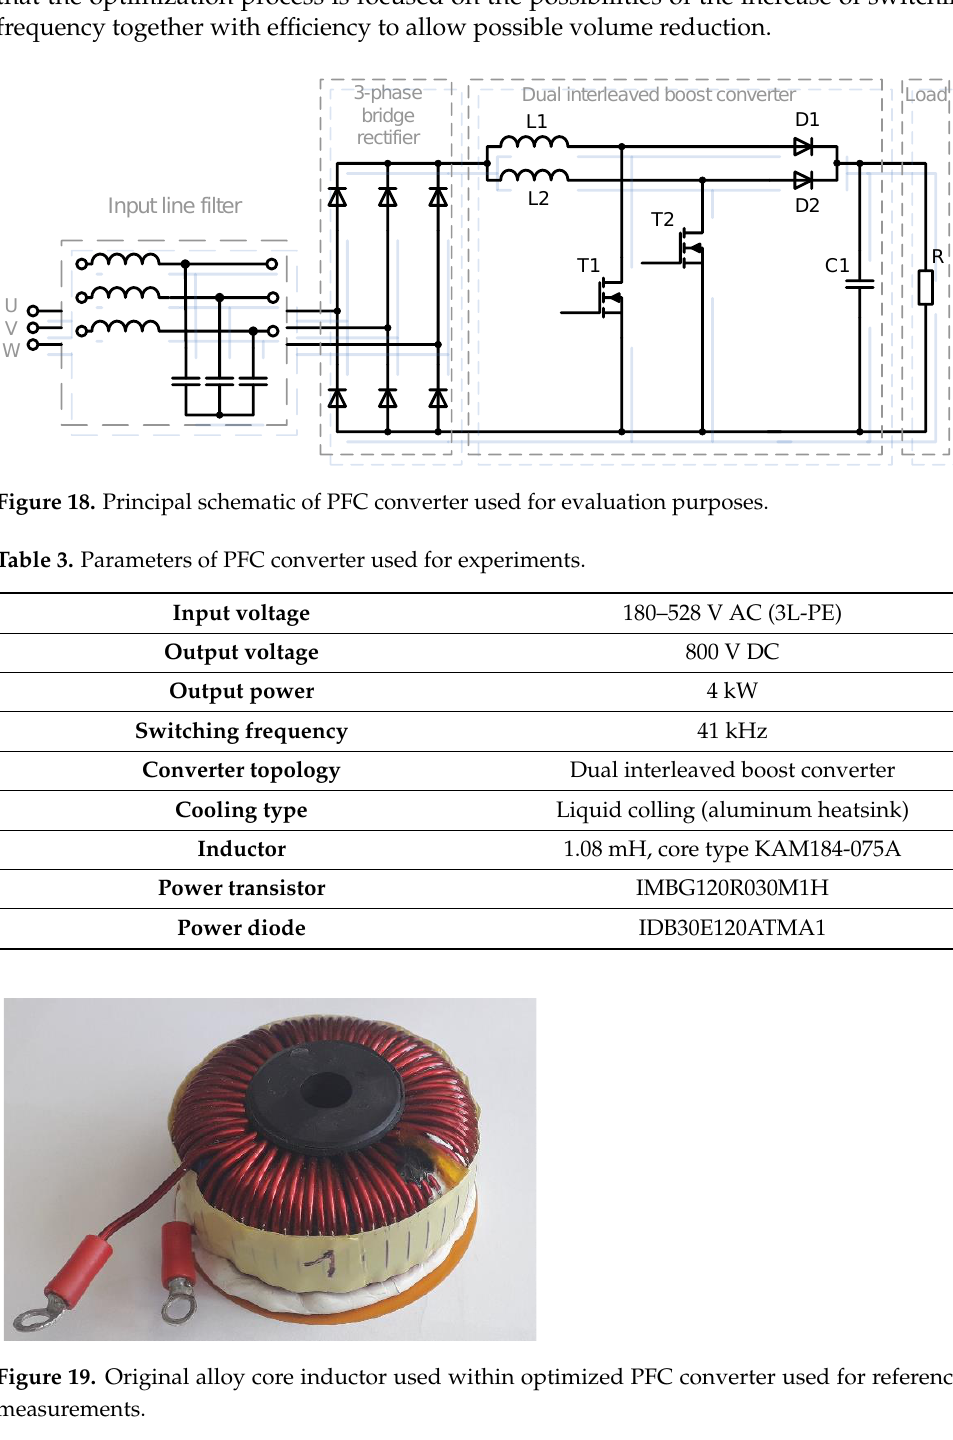
Table 3. Parameters of PFC converter used for experiments.